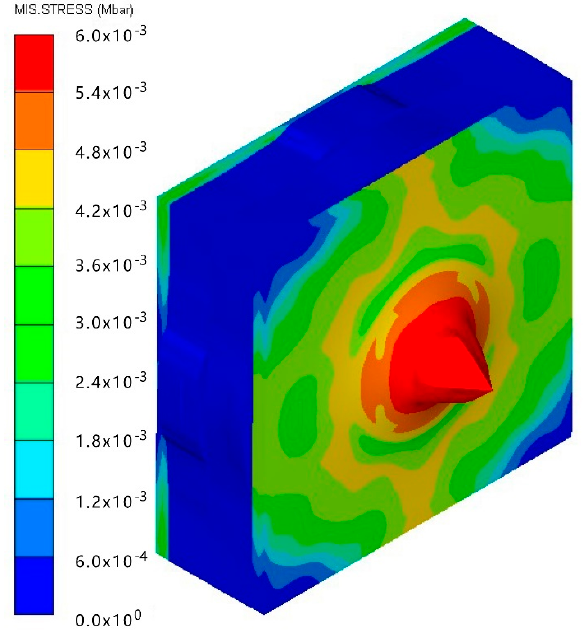
Figure 4. Von-Mises stress contour of armor at the impact velocity of 1300 m/s.